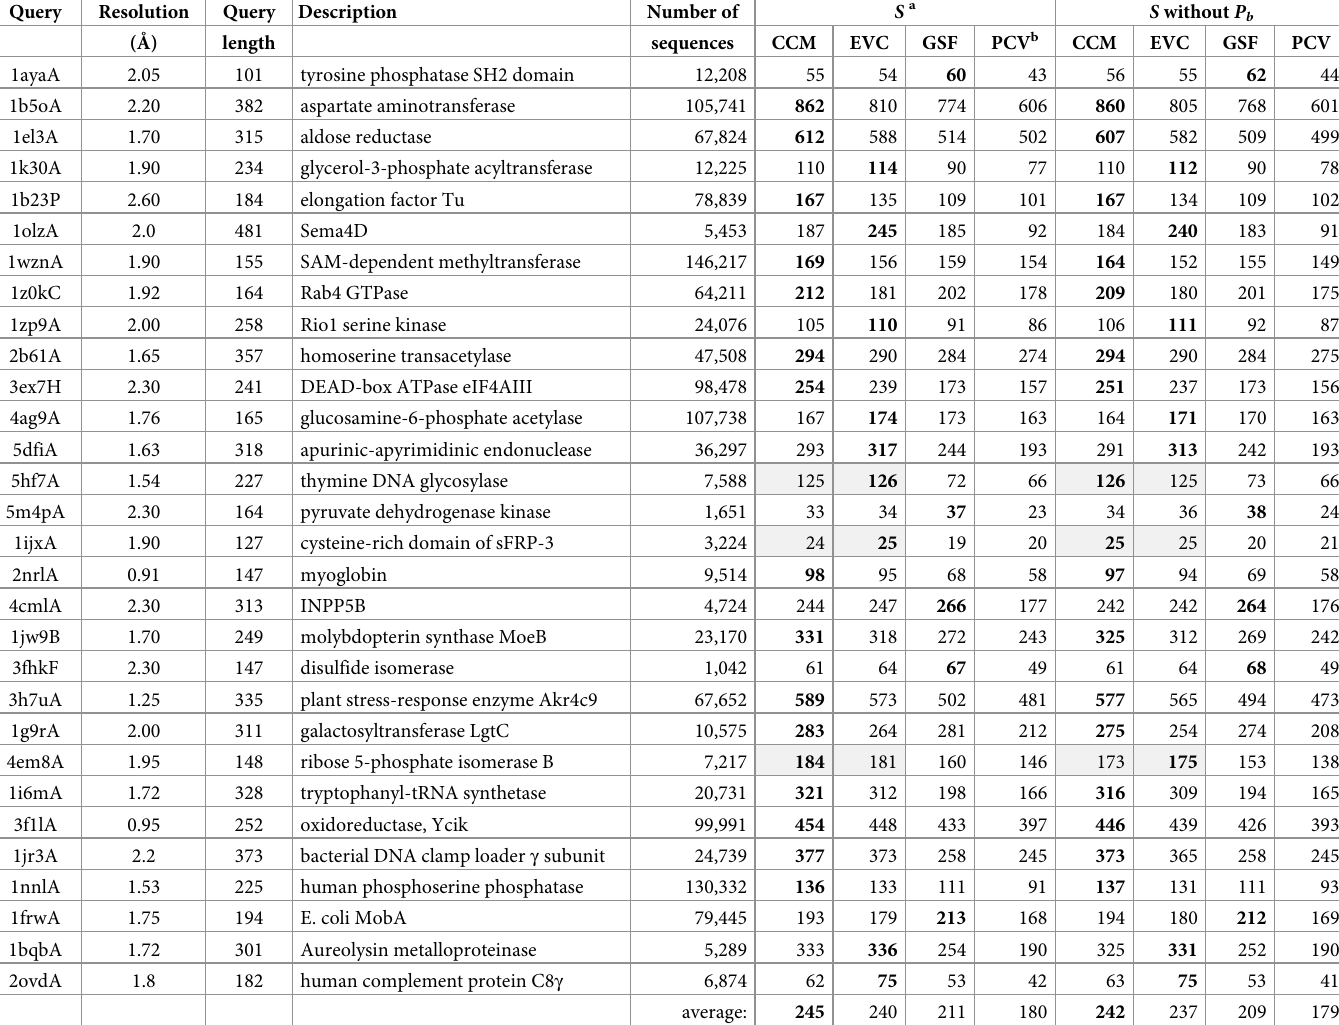
Table 2. S calculated with and without P for thirty superfamilies using residue pairwise 3D distances � 5 Å and a minimum of 5 intervening b